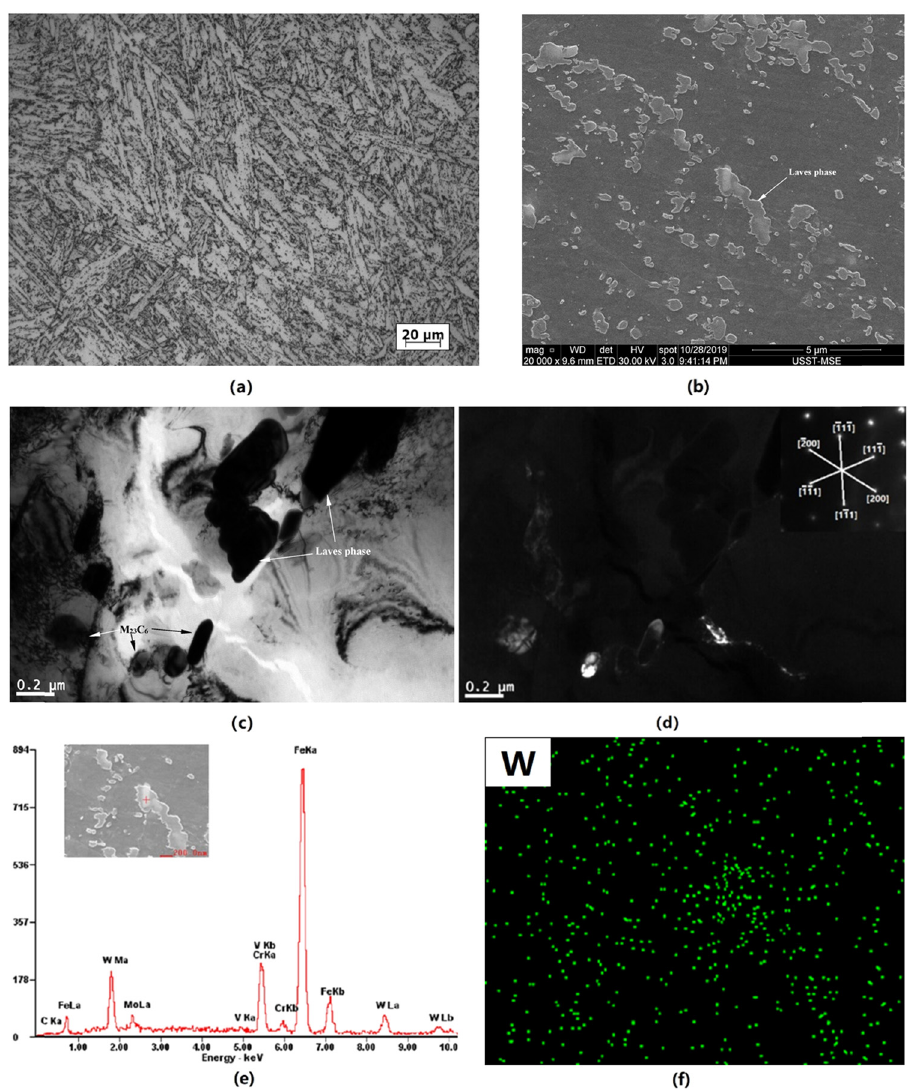
Figure 6: ( a ) OM image, ( b ) SEM image, ( c ) TEM bright - fi eld image, ( d ) TEM dark - fi eld image and SAED of M 23 C 6 , ( e ) SEM – EDS result of P92 steel after 650°C – 29,000 h aging, and ( f ) SEM – EDS mapping image of W in P92 steel after 650°C – 29,000 h